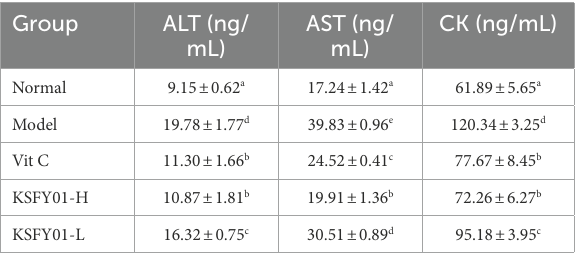
TABLE 3 The ALT, AST, and CK levels in aging mouse.